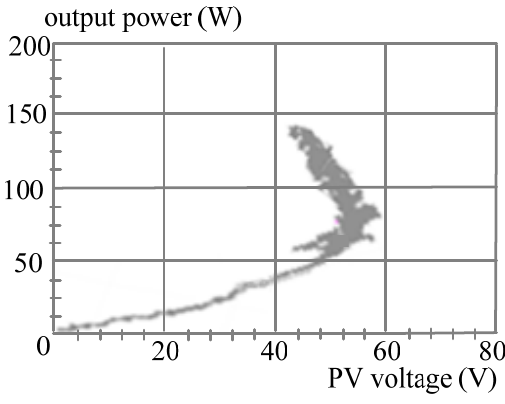
Figure 16. Practical measurement of the PV power system with the POM.